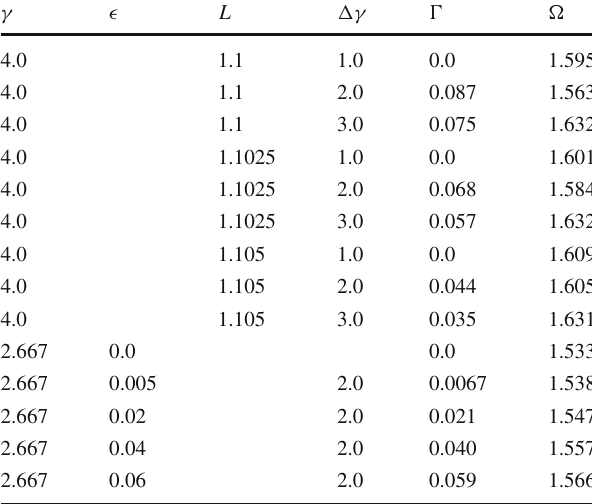
Table 1 Values of the oscillation frequency (cid:12) and decay rate (cid:13) for the different values of the parameters used in the